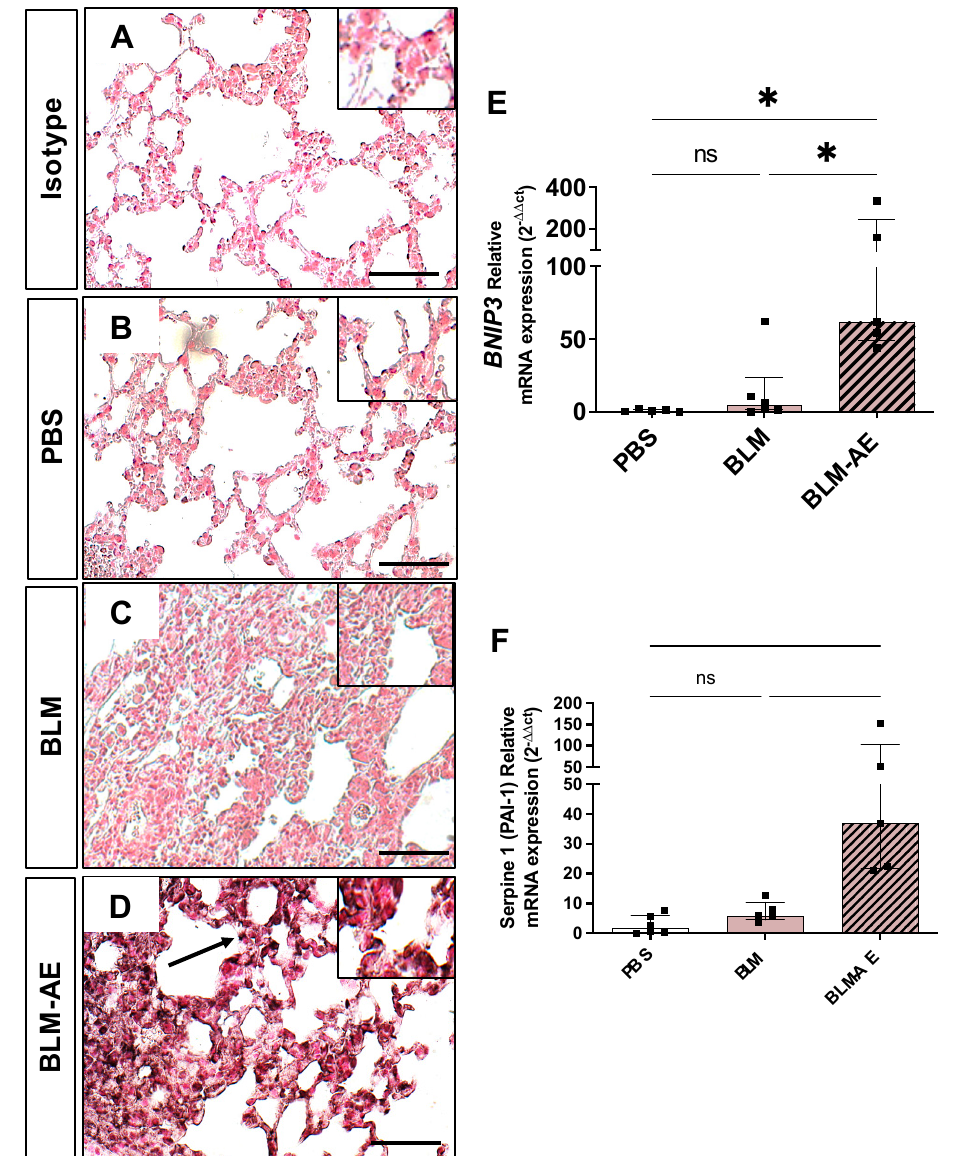
Figure 7. Hypoxia-induced factor HIF-1 α immunostaining and expression level of target genes. ( B – E ) Photographs of 5 μ m serial lung sections immunostained for HIF-1 α protein and a rabbit isotype. (Scale bar corresponding to 50 μ m). A representative image of the PBS ( B ), BLM ( C ), and BLM-AE ( D ) groups was shown. When reported to the staining of isotype ( A ), no significant HIF-1 α staining was observed in the BLM group as compared to the PBS control group. Significant increase staining of HIF-1 α is observed in the BLM-AE group mainly localized in modified alveolar epithelial cells (black arrow) ( D ). ( E ) mRNA expression of BNIP3 and ( F ) mRNA of SERPINE1 (PAI-1) quantified by RT-qPCR from the control PBS group (white bar), BLM group (pink bar) and BLM-AE group (pink hatched black bar). Effect of BLM or BLM-AE was presented as fold induction normalized to the mean value of PBS group and reported to 1. All values are represented as median ± interquartile range; one-way ANOVA analysis followed by Newman–Keuls was performed. ns: not significant, * p ≤ 0.01.